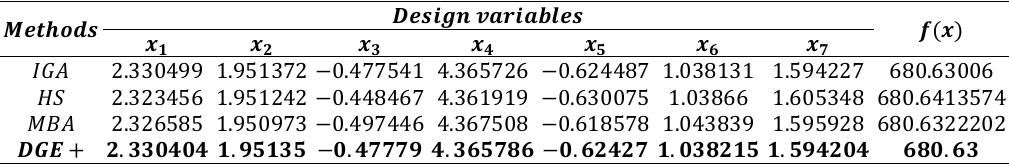
Table 10. Reported results for constrained problem 6 from different optimizers